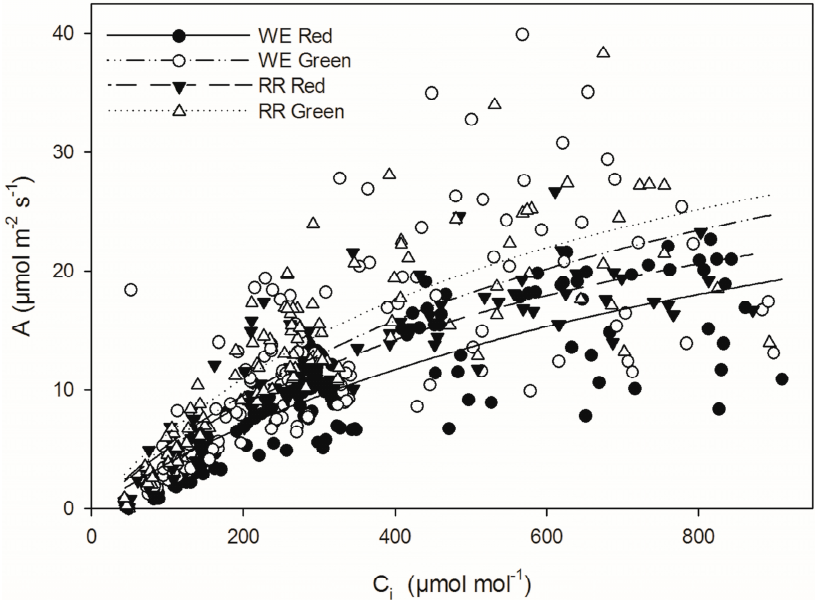
Table 2. Mean values obtained from A/C i curves at individual and combined sites. Data